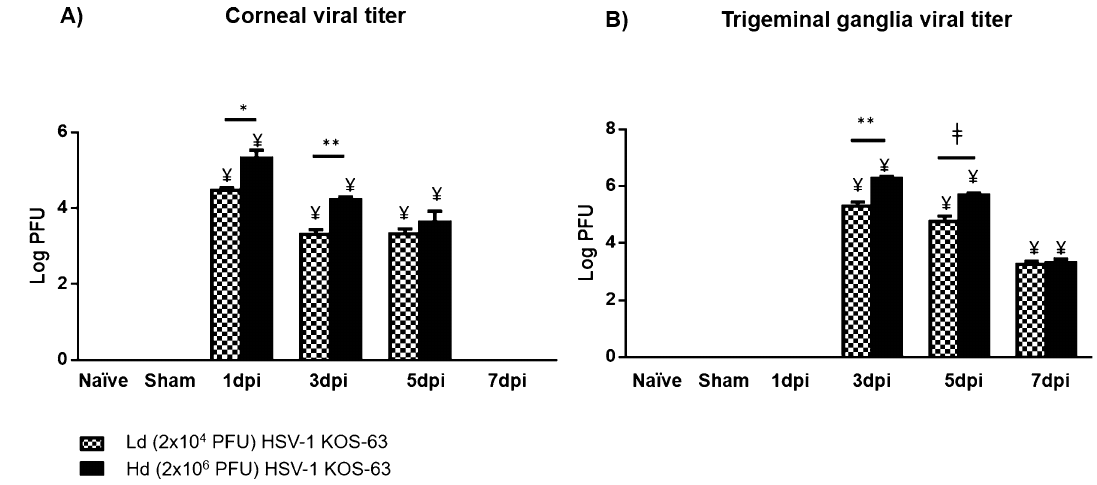
Figure 3. The viral titer levels in corneas and trigeminal ganglia (TG) of Ld and Hd HSV-1 KOS-63 infected mice at 1, 3, 5, and 7 days dpi. Corneal and TG of naïve and sham-infected mice served as controls. ( A ) Mean viral titer in corneas; Hd infected mice had higher viral titer at 1dpi (* p = 0.004) and 3 dpi (** p = 0.001). ( B ) Mean viral titer in the TGs; It demonstrated higher titers in the Hd-infected mice compared to Ld-infected mice at 3 dpi (** p = 0.0008) and 5 dpi ( ǂ p < 0.0001). At each time point 6–10 TGs or corneas, from 6 to 10 mice and from 3 to 4 independent experiments, were homogenized and tittered in pairs (2 corneas or 2 TGs were homogenized in a same tube for titration). Bars are showing mean ± SEM. ANOVA: p < 0.0001. ¥, demonstrates the statistical significance ( p < 0.05) between the marked column and naïve and sham-infected. p values are calculated by one-way ANOVA followed by Tukey’s multiple comparison test.